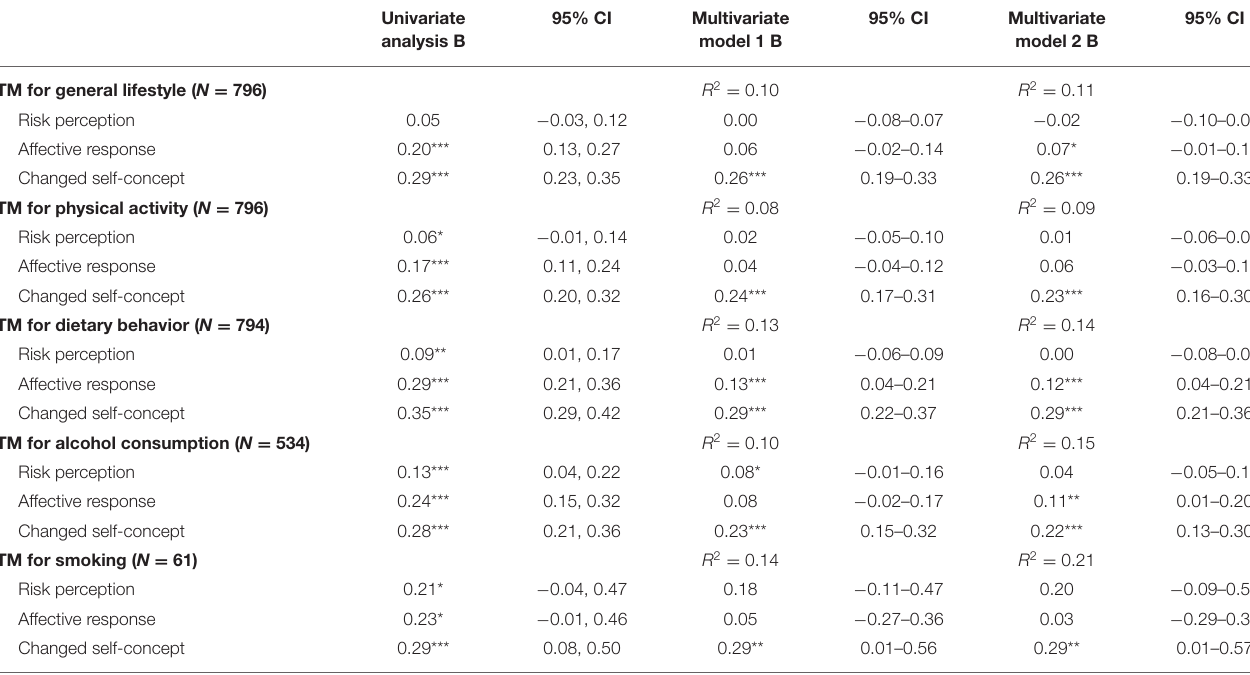
TABLE 4 | Univariate and multivariate regression